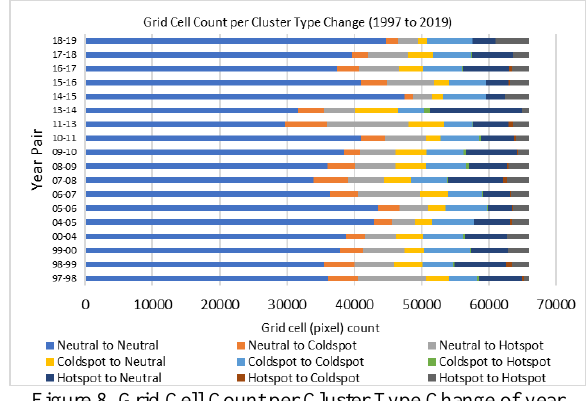
Figure 8. Grid Cell Count per Cluster Type Change of year pairs from 1997 to